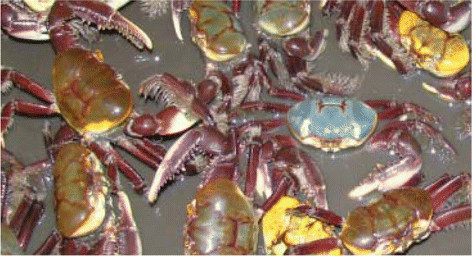
Different color patterns forUcides cordatusin the fishing community of Sempre Viva, Conde, Bahia State. Photo by Henrique F. de Magalhães.